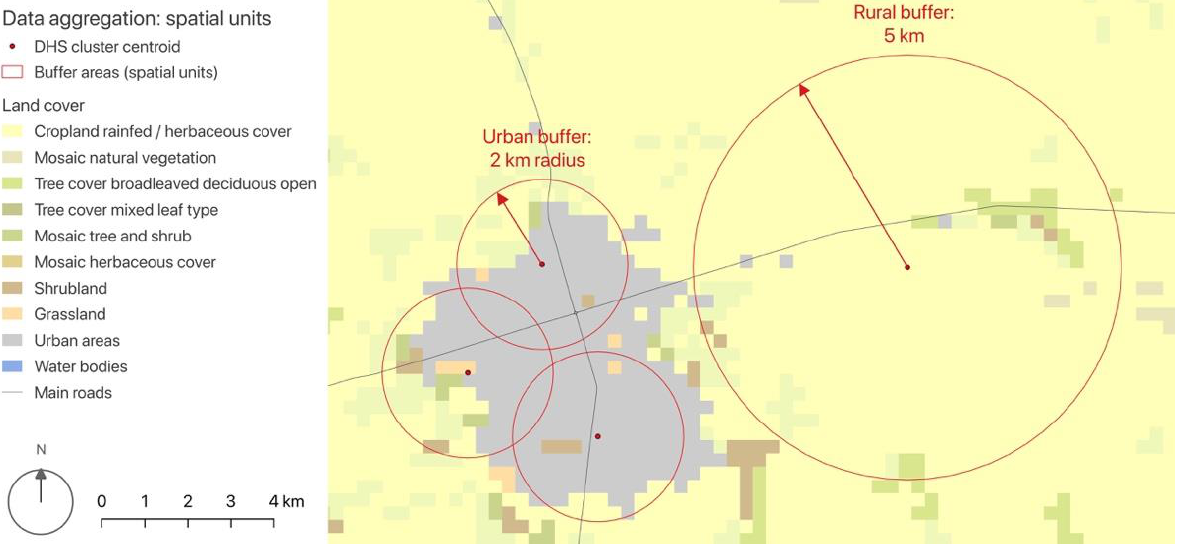
Figure 1. Buffer areas (red circles generated from DHS clusters’ centroids) were used as reference areas to calculate landscape metrics. Elaborated by the authors with QGIS, from: DHS [28] and ESA Land Cover CCI [36]. © ESA Climate Change Initiative — Land Cover led by UCLouvain (2017).